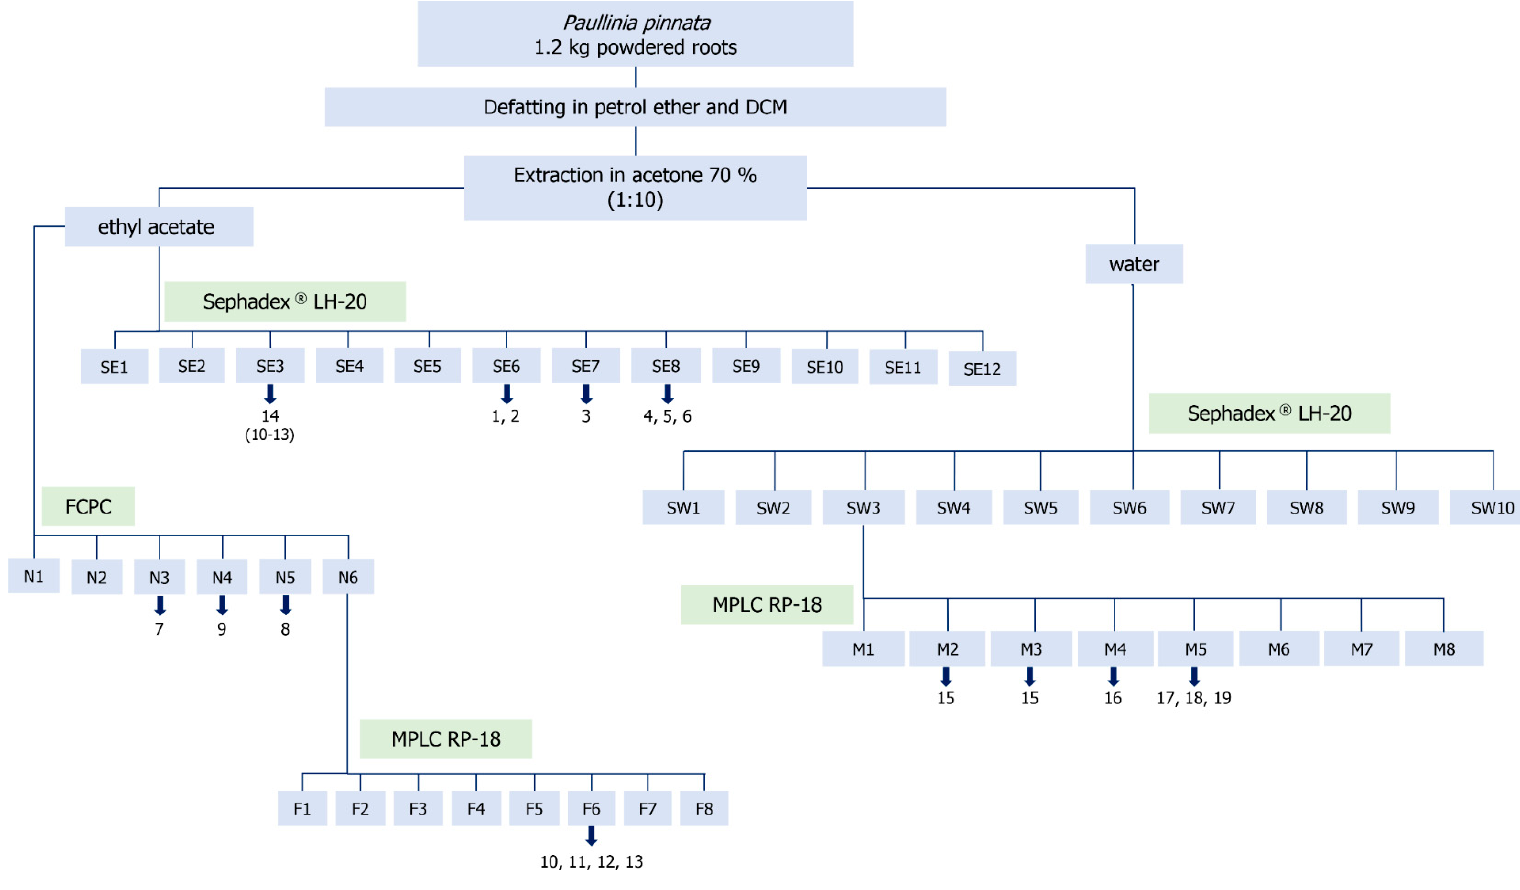
Figure 1 . Extraction and fractionation scheme of roots and root extract from Paullinia pinnata .